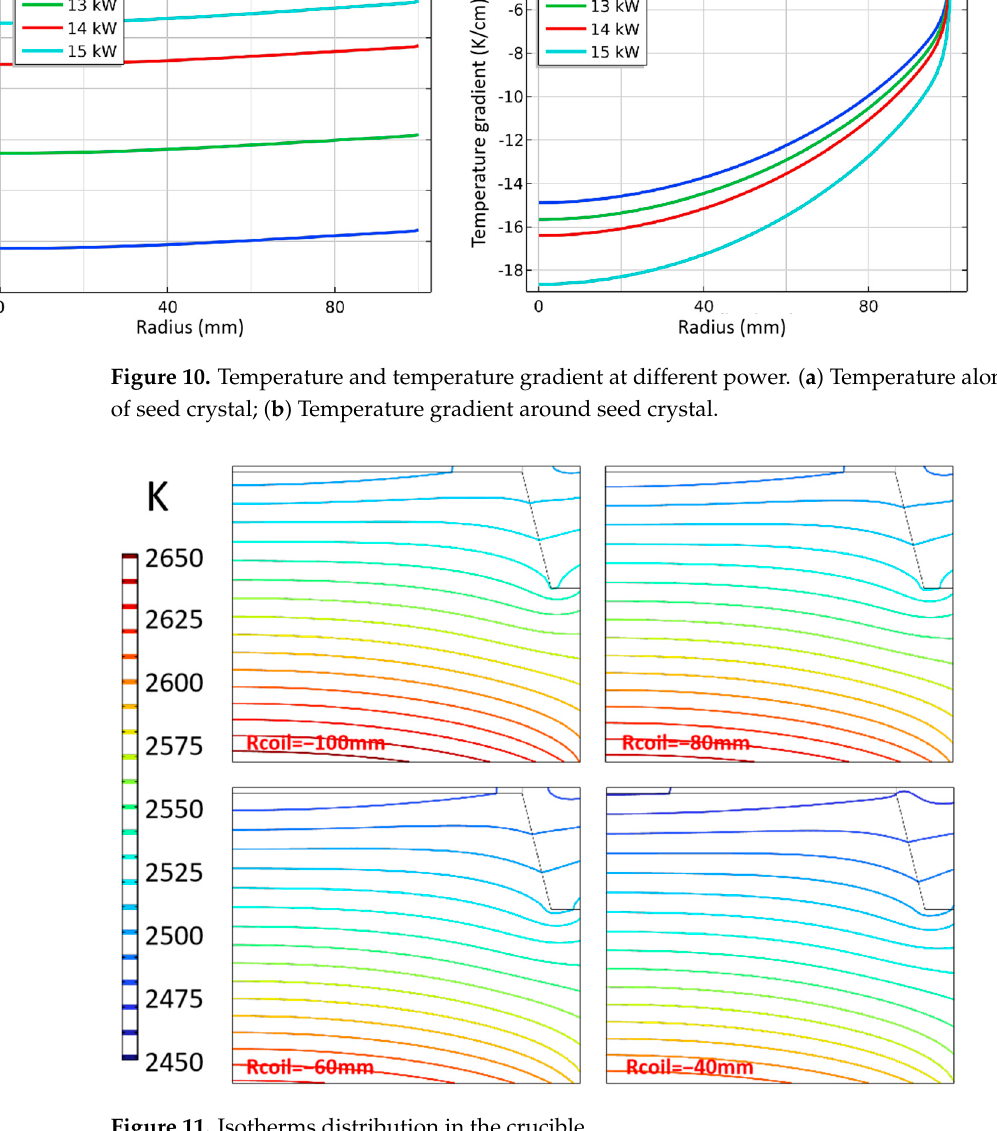
Figure 11. Isotherms distribution in the crucible.